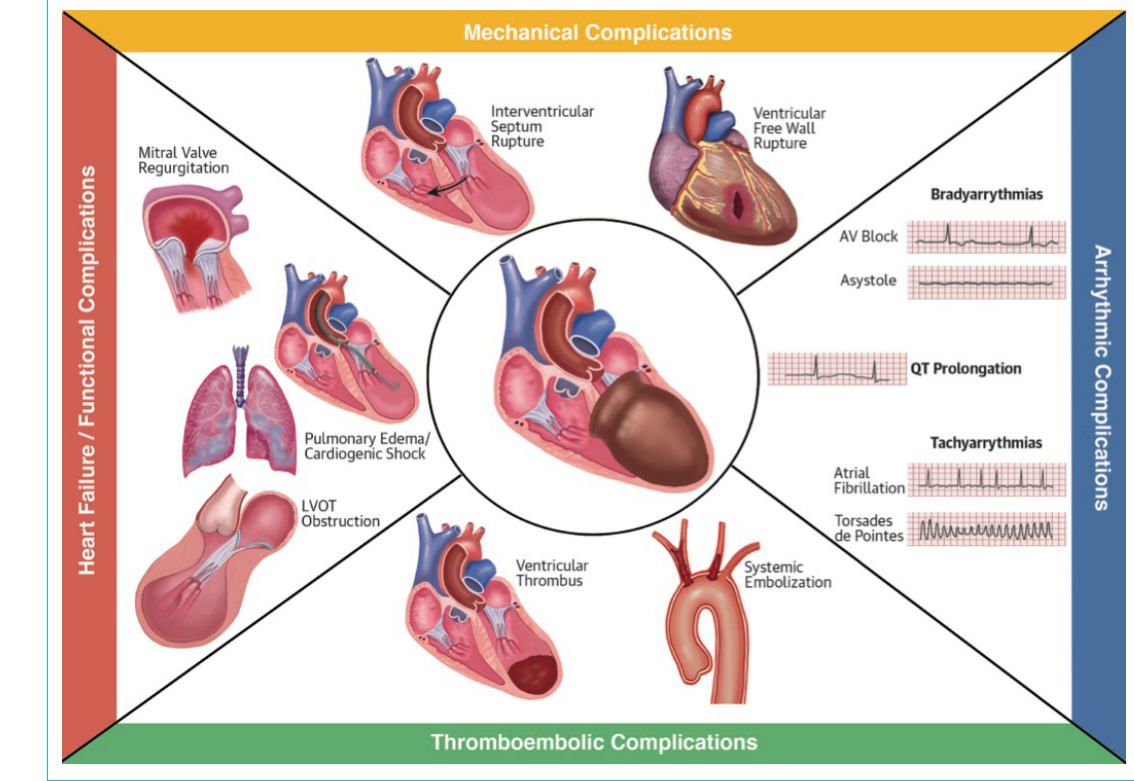
Figure 4: Different complications that can occur in Takotsubo syndrome. Complications are divided into heart failure and functional complica- tions as well as mechanical, arrhythmic and